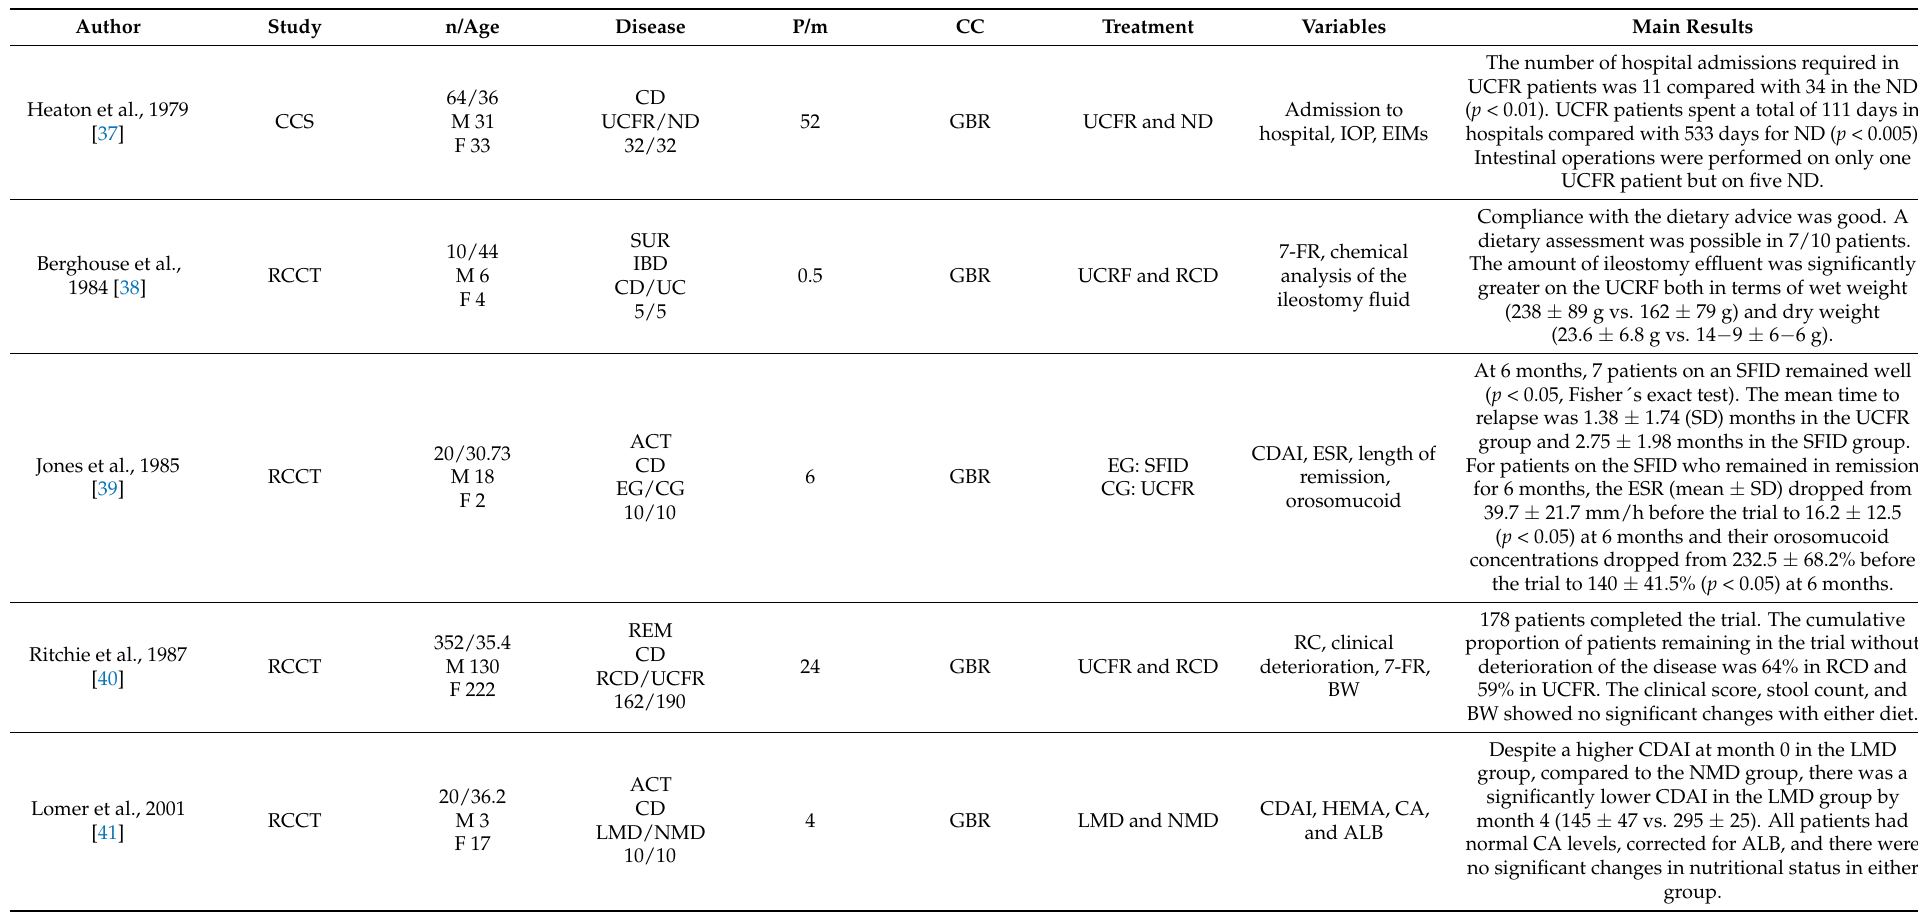
Table 2. Main results of the systematic